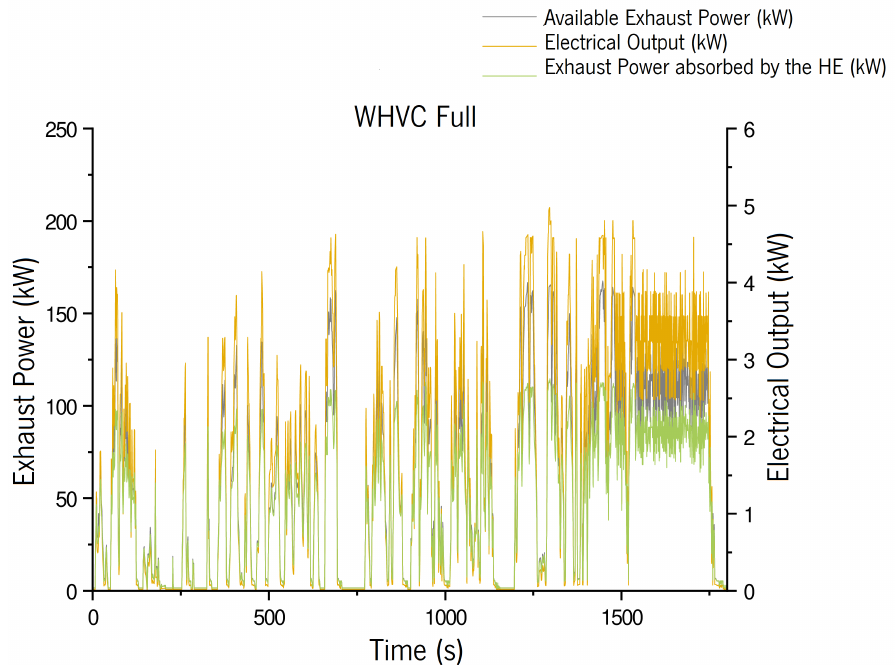
Figure 12. Results of the TEGs generated power, absorbed exhaust power and the available exhaust power for WHVC driving cycle with 25.5